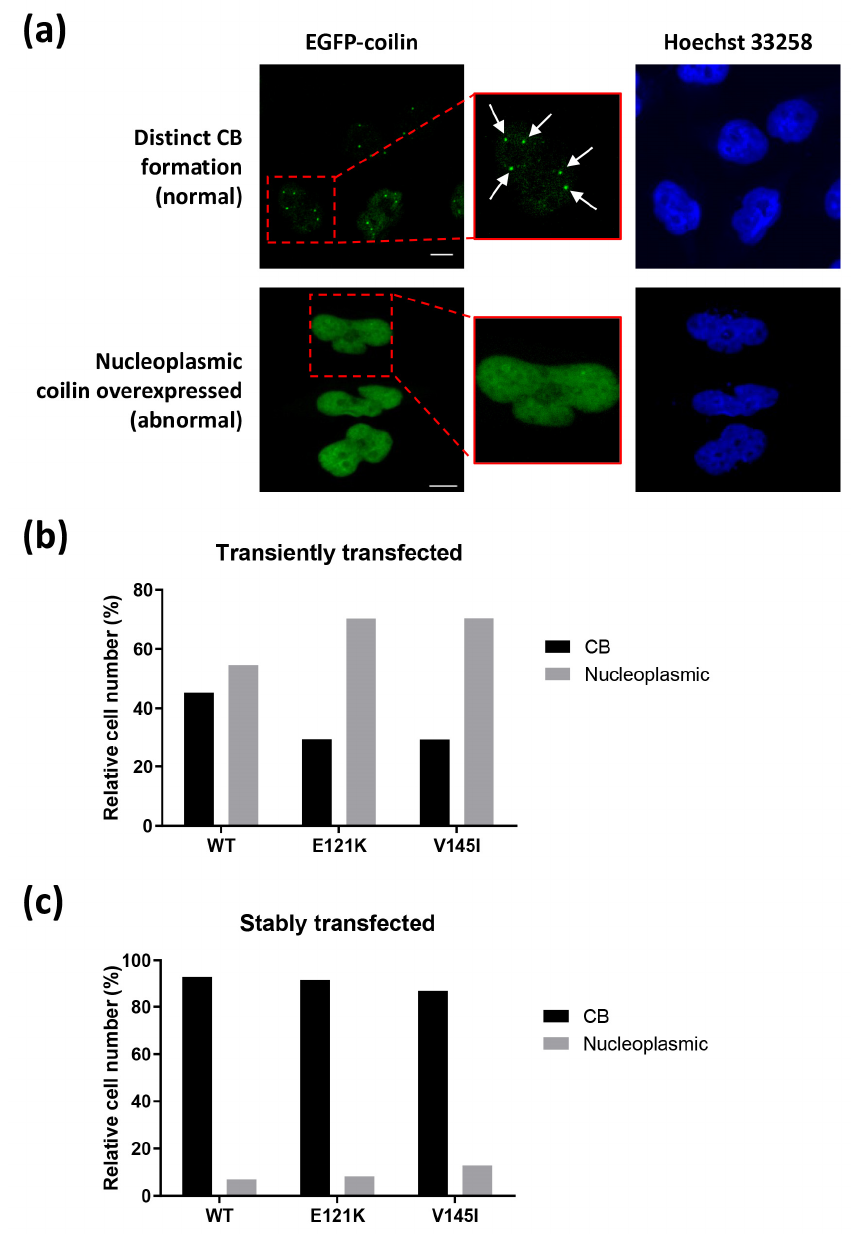
Figure 2. Effects of transiently and stably expressed coilin wild-type (WT) and SNP variants on Cajal body (CB) formation. ( a ) Immunofluorescence analysis of HeLa cells with normal (indicated by single arrow) and abnormal CB formation; scale bar = 10 µm. ( b ) HeLa cells were transiently transfected with coilin WT ( n = 108), E121K ( n = 118), or V145I ( n = 132) and observed for CB formation. ( c ) HeLa cells were stably transfected with coilin WT (n = 156), E121K ( n = 145), or V145I ( n = 180) and observed for CB formation.